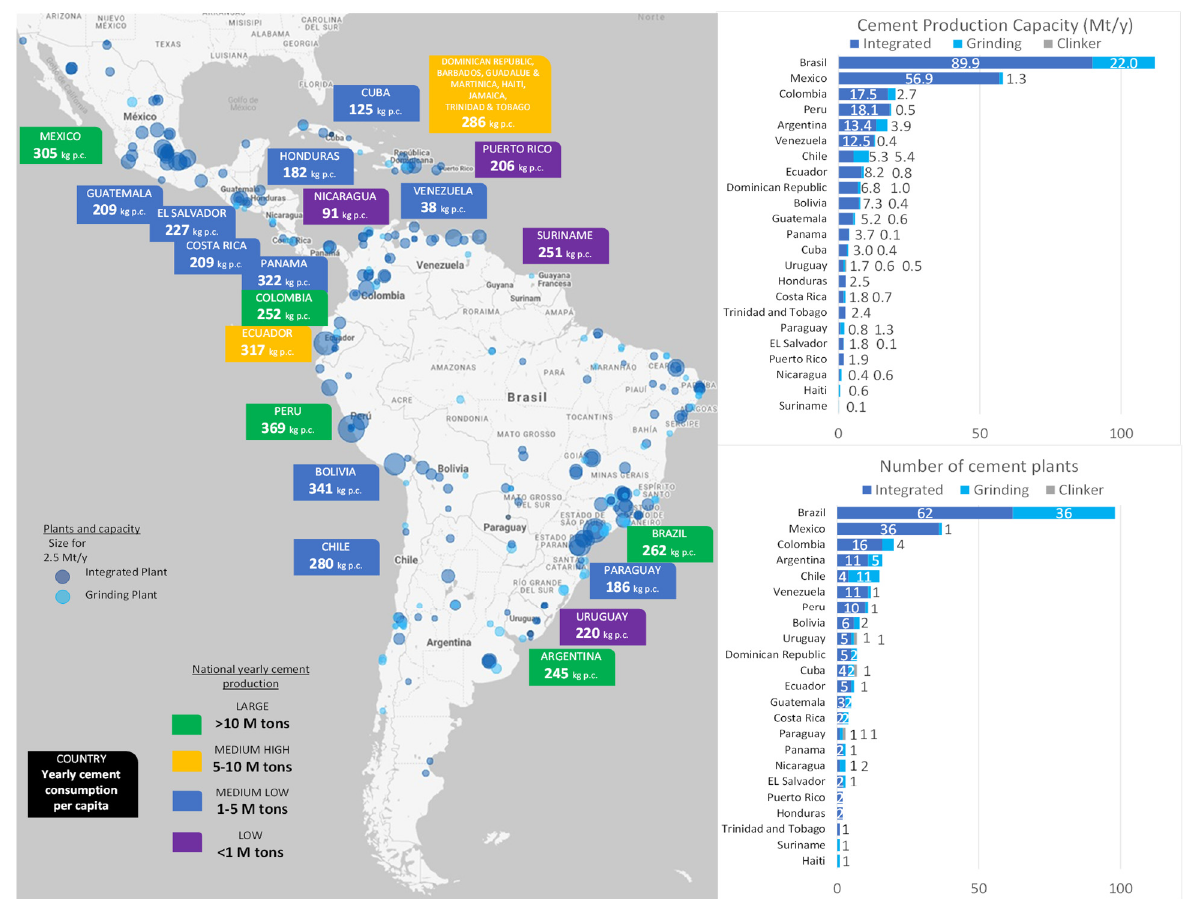
Figure 1. Latin American cement plants (source: FICEM, 2019), yearly cement consumption per capita and national cement production